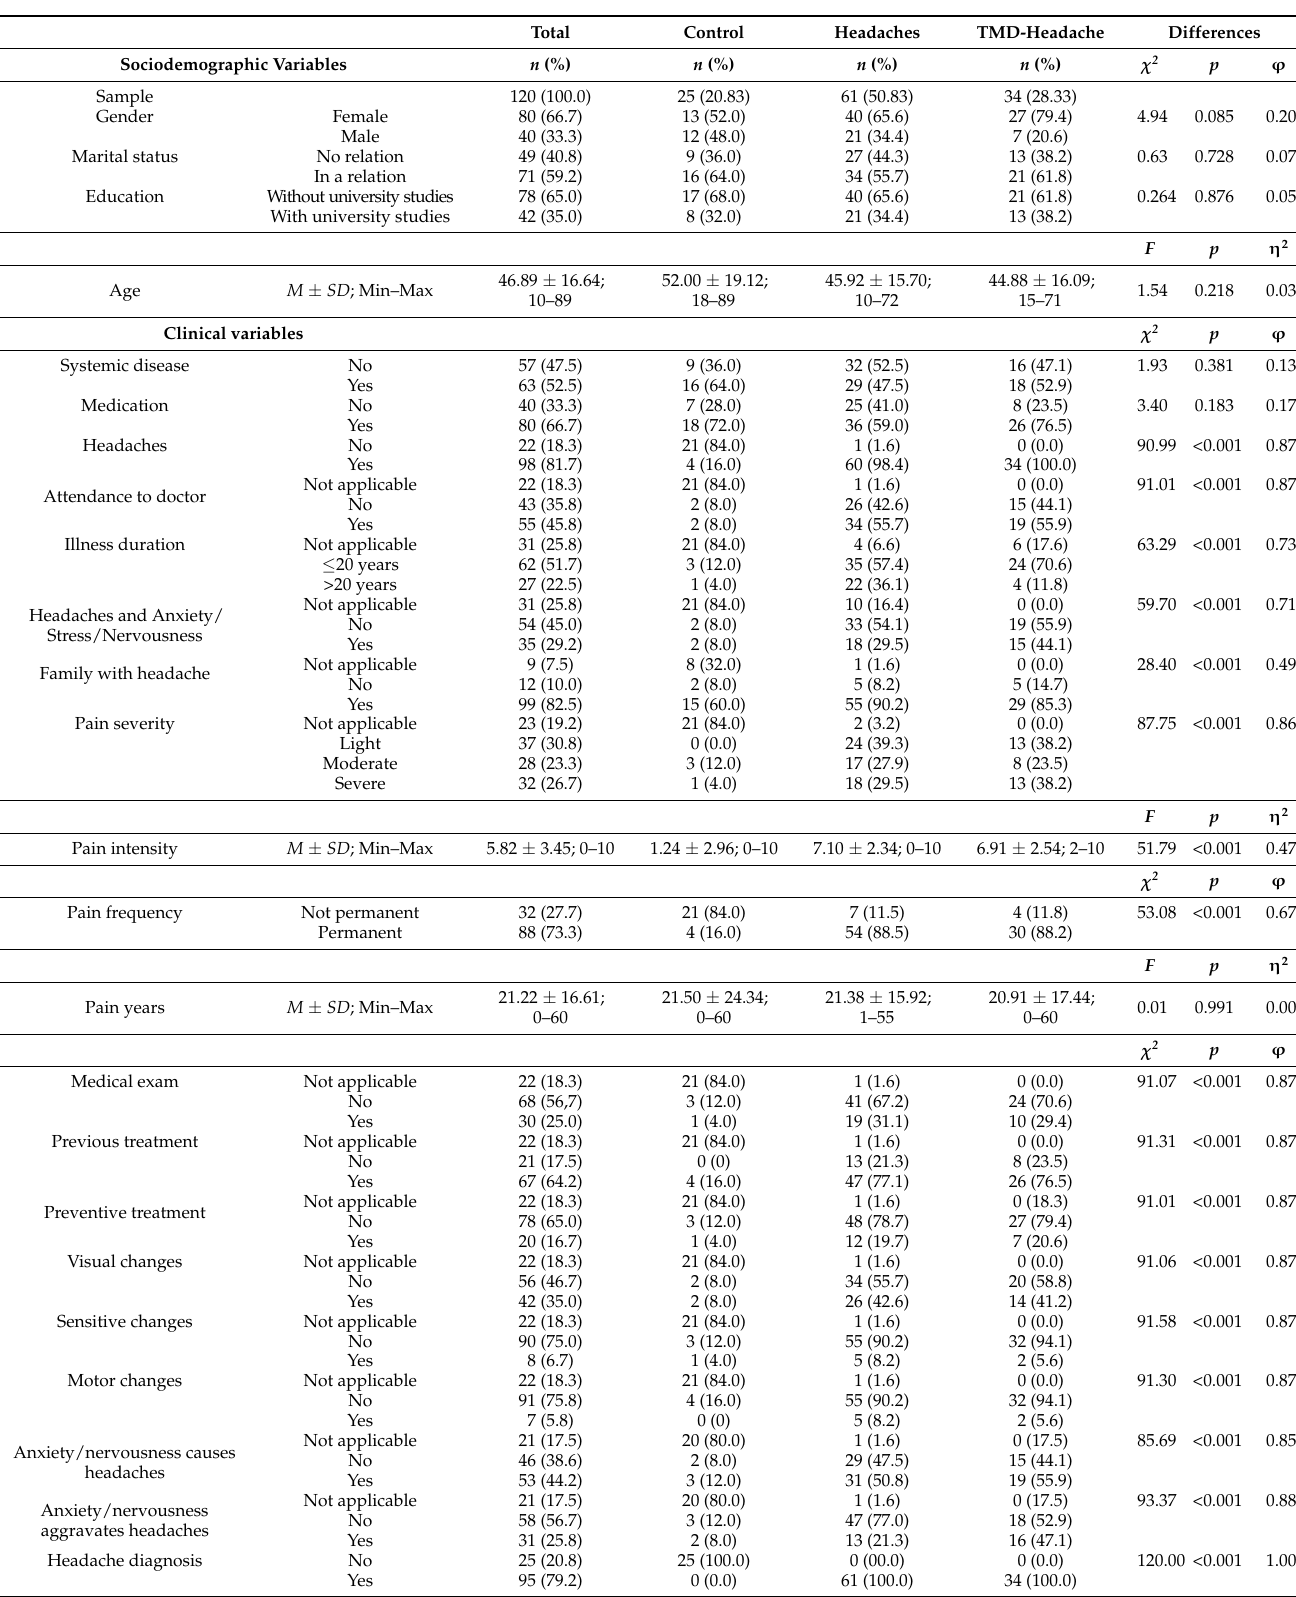
Table 1. Sample’s sociodemographic and clinical characteristics: differences between